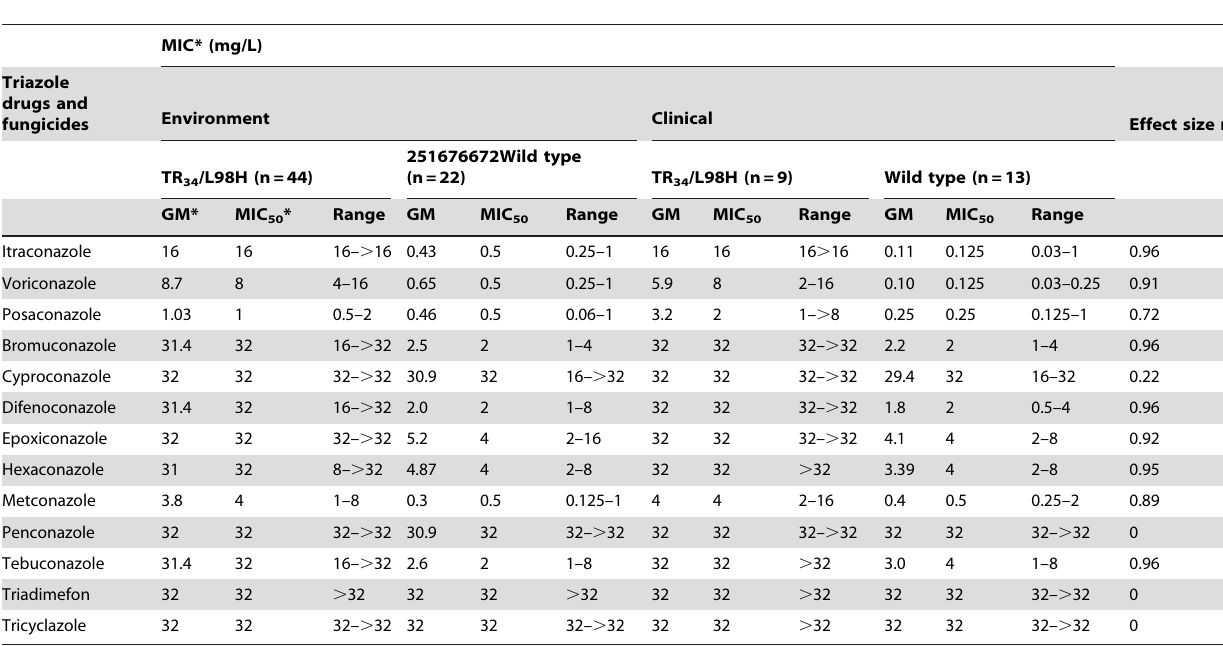
Table 2. In- vitro antifungal susceptibility profile of medical triazoles and triazole fungicides against environmental and clinical Aspergillus fumigatus isolated in